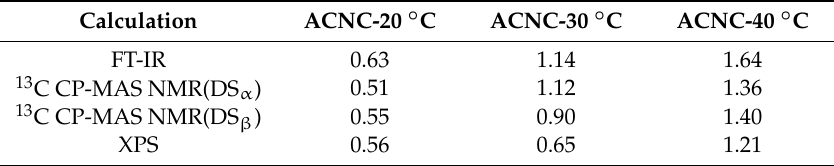
Table 1. Degree of substitution (DS) calculated results of ACNC